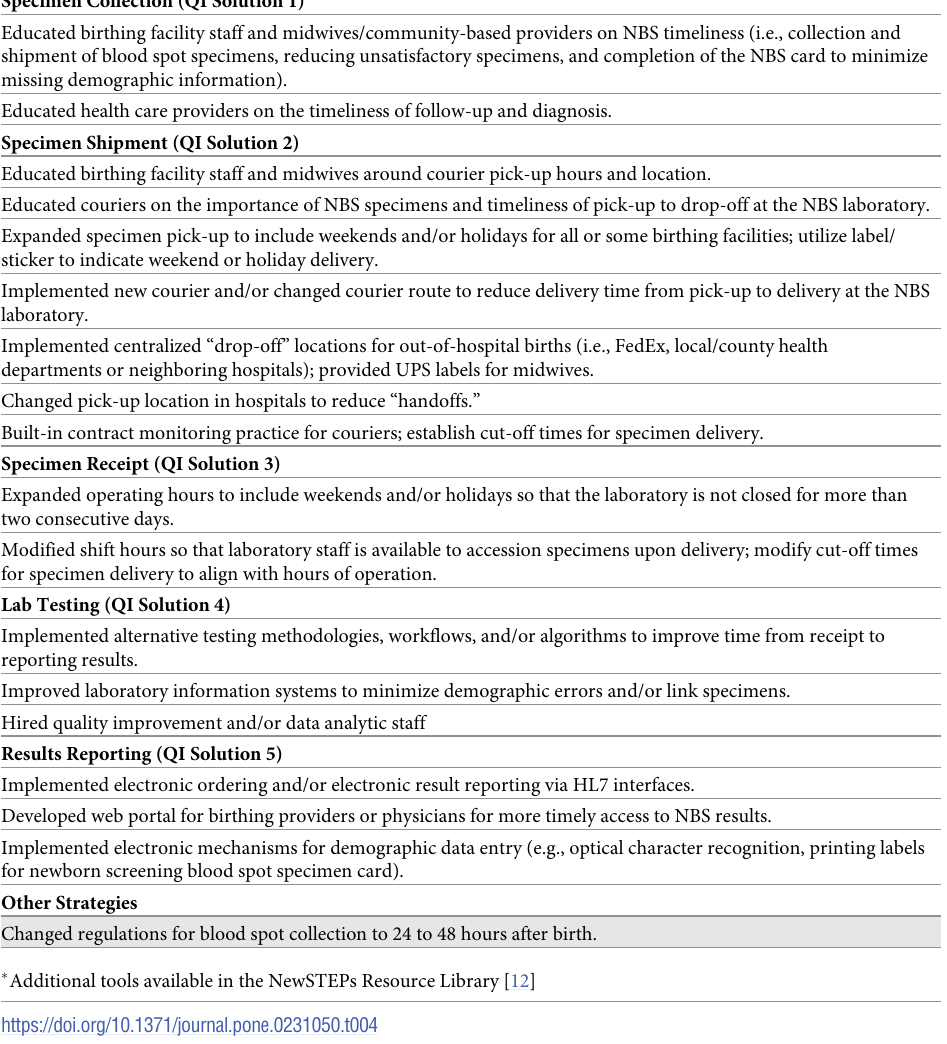
Table 4. List of strategies participating NewSTEPs 360 programs used to improve NBS timeliness. � Each Strategy is Linked to a Corresponding QI Solution in Fig 1. Specimen Collection (QI Solution